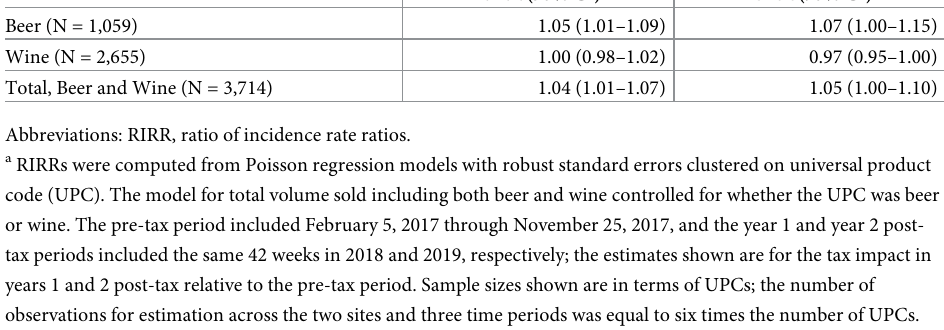
Table 2. Difference-in-differences estimates of the impact of the Seattle, Washington, sweetened beverage tax on volume sold of alcoholic beverages in Seattle relative to Portland, Oregon, 2017–2019 a .